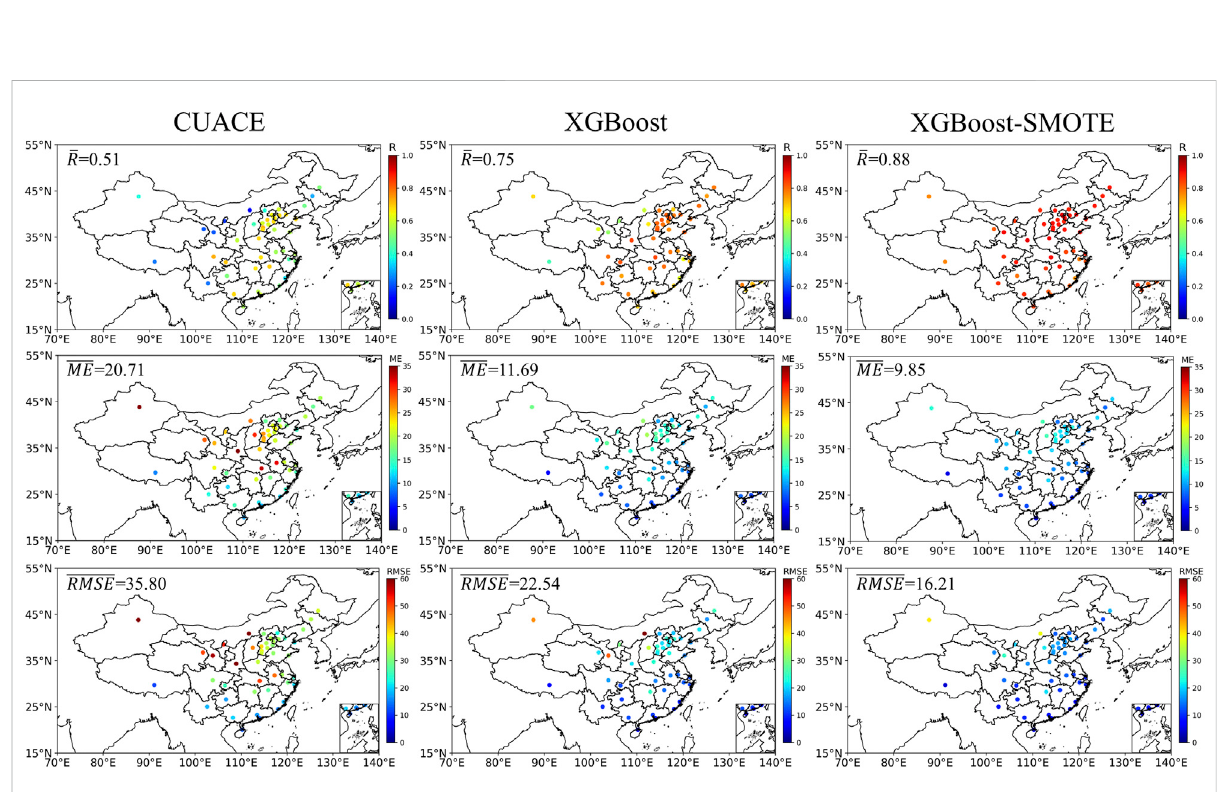
FIGURE 4 Performance comparison of the 1st-day PM 2.5 forecasting results for the original CUACE, XGBoost, and XGBoost-SMOTE